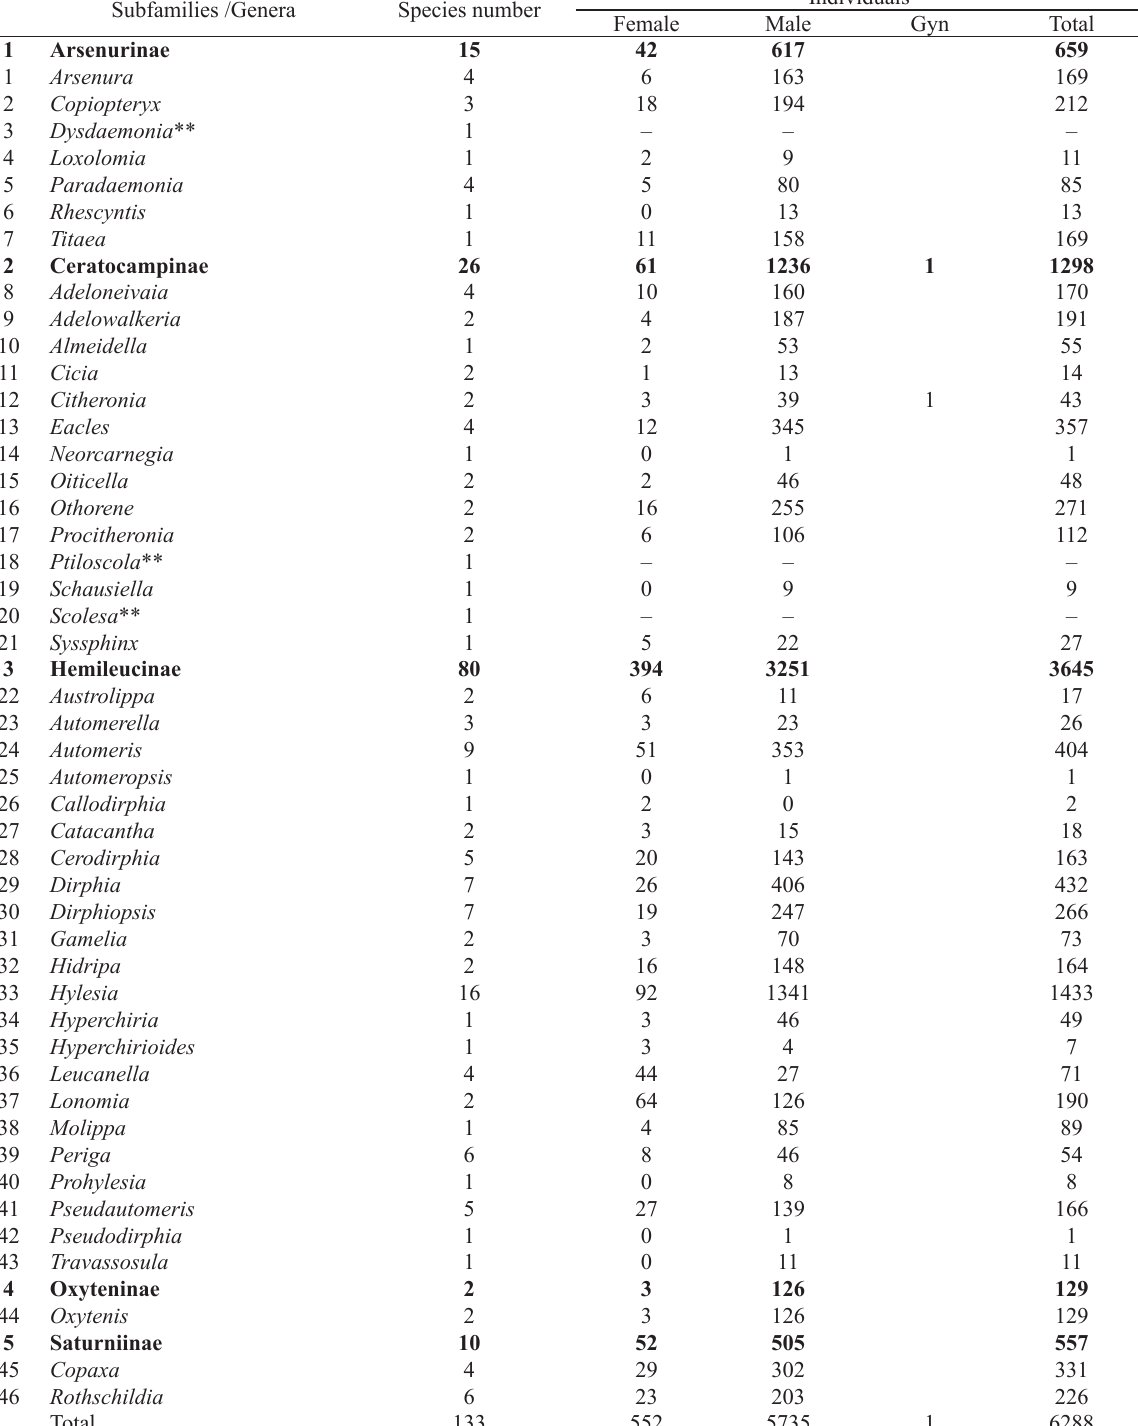
Number of species and individuals of all genera in each subfamily of Saturniidae, collected from the Boraceia Biological Station between 1942 and 2013. Gyn=